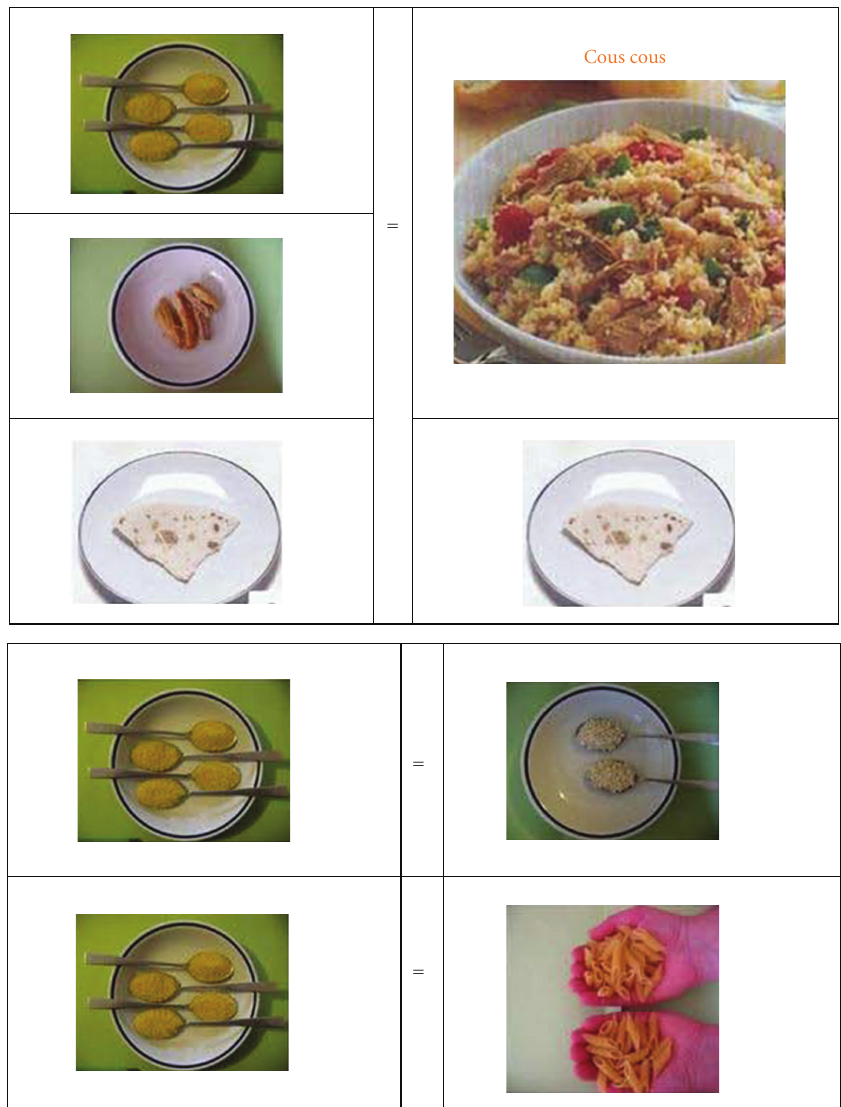
Figure 1: Example of ethnic meal